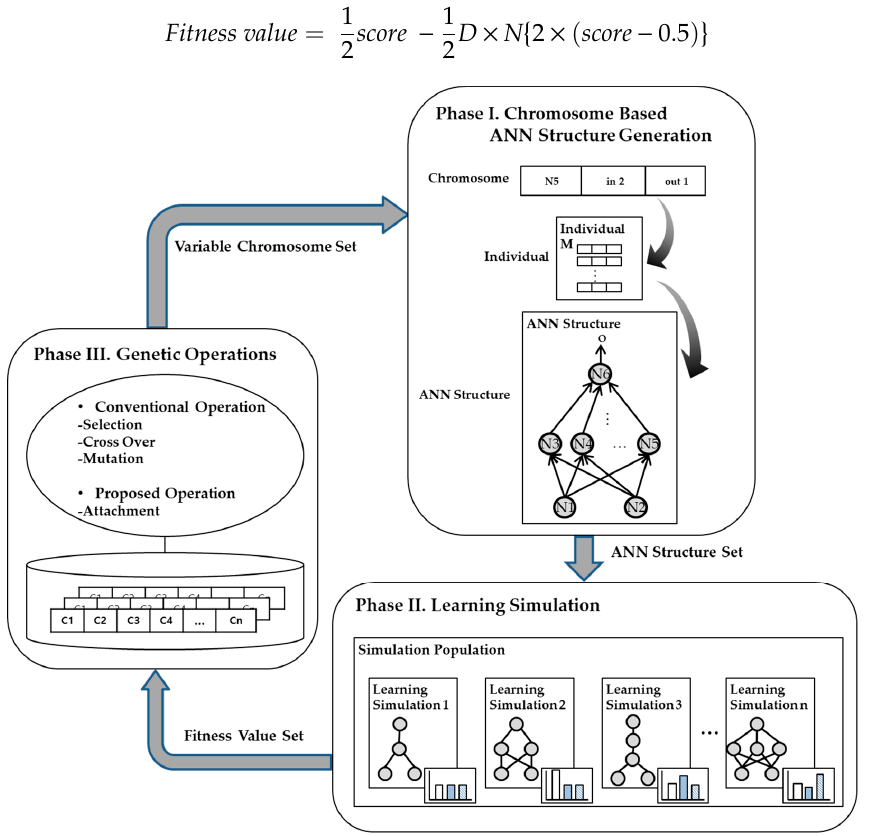
Figure 1. Overall methodology.